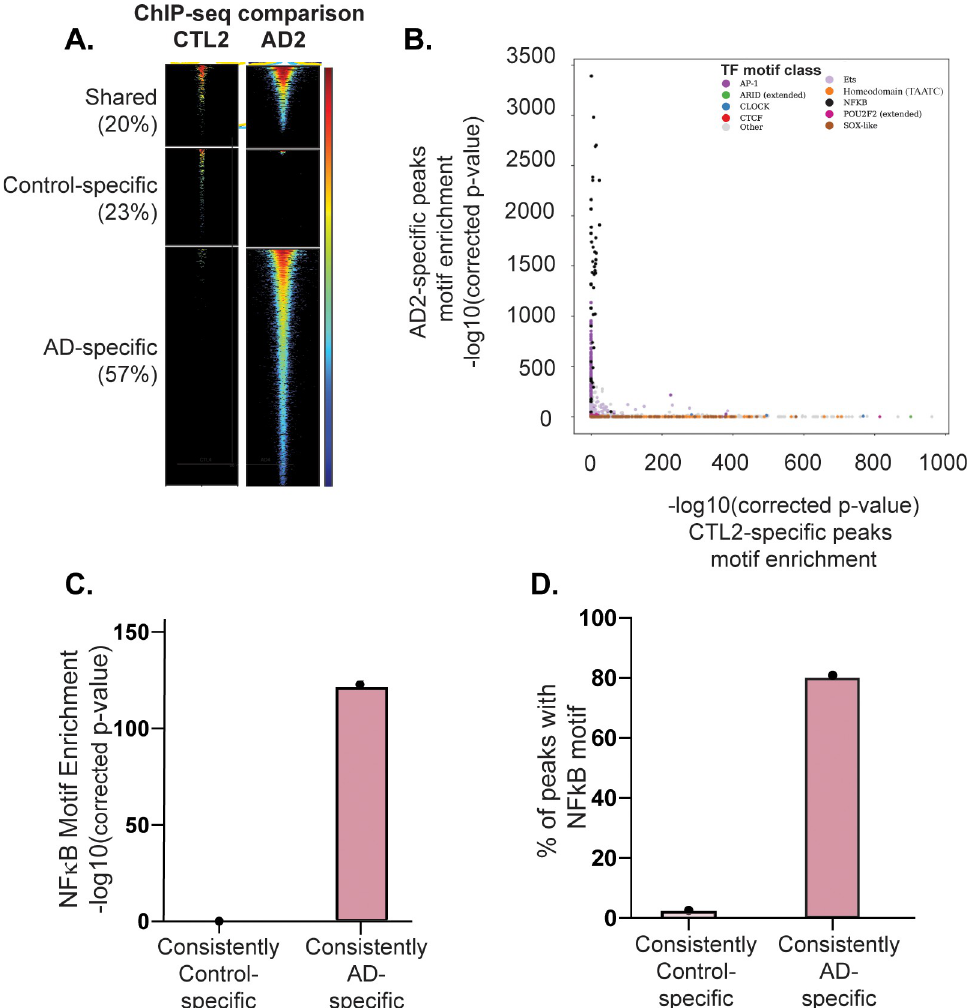
Fig 4. Differential NFKB1 binding and TF motif enrichment in AD subjects vs. matched controls. NFKB1 ChIP-seq peaks were identified for all case and control subjects and compared between matched subject pairs. (A) Differential NFKB1 binding analysis. For each matched pair of subjects, we identified the shared peaks, control-specific peaks, and AD-specific peaks (see METHODS). A representative subject pair is shown in (A). Each row represents a single genomic locus, where an NFKB1 ChIP-seq peak was identified in either the AD or control subject. The center of each row corresponds to the center of the ChIP-seq peak. Heatmap colors indicate the normalized ChIP-seq read counts within the AD2 (right) or CTL2 (left) subject–see key on the right. (B) Differential TF motif enrichment analysis. Comparison of TF motif enrichment results within a representative AD-specific and control-specific matched subject pair. Each dot represents the enrichment of a particular motif (corrected negative log 10 p-value). Select motif families are color-coded (see key on the upper right side). (C and D) NFKB motif enrichment comparison between consistently AD-specific and consistently control-specific NFKB1 ChIP-seq peaks. “Consistently specific” peaks were defined as those peaks that were AD- or control-specific in at least three case or control subjects, respectively. Results are shown for representative Cis-BP NF- κ B motif, M05887_2.00. All results are listed in S7 and S9 Tables